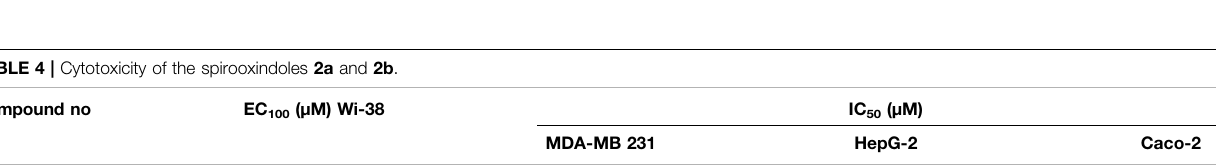
TABLE 4 | Cytotoxicity of the spirooxindoles 2a and 2b . Compound no EC 100 (µM) Wi-38